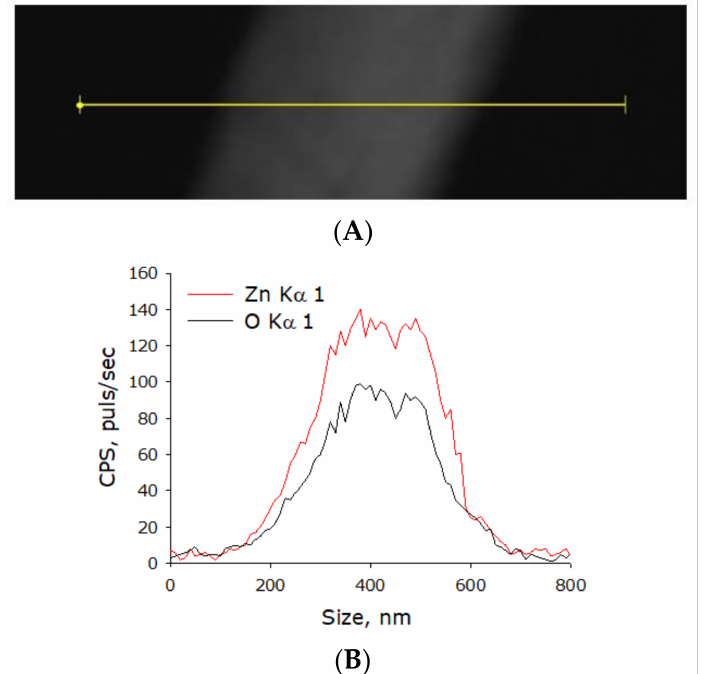
Figure 9. Elemental analysis of zinc oxide nanorods. ( A ) TEM image of group of zinc oxide nanorods; analysis section is indicated by line. ( B ) Nanorods profile by Zn K α 1 and O K α